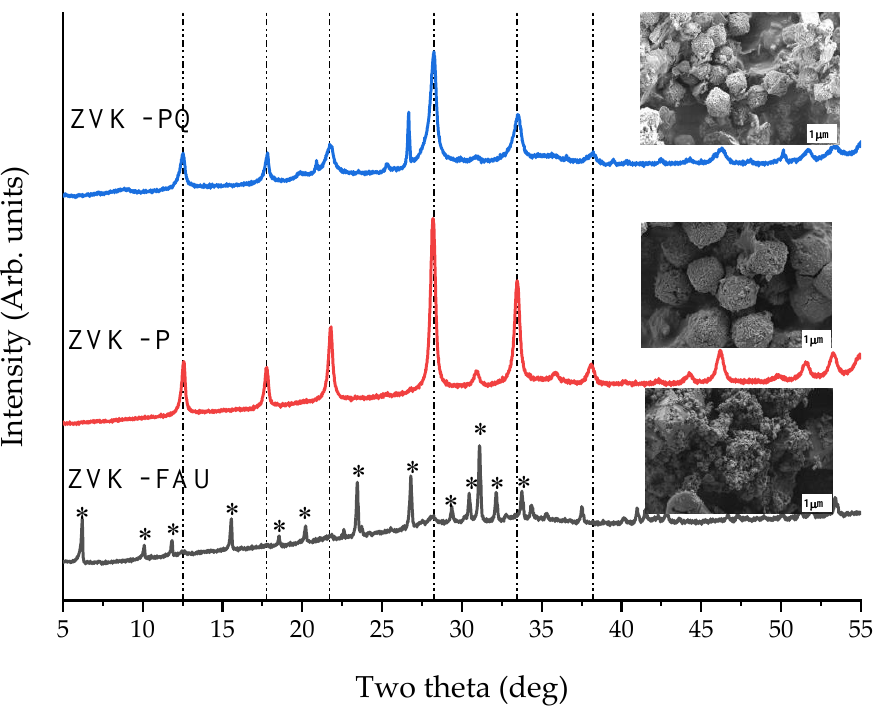
Figure 3. XRD patterns of zeolites from VK with no pretreatment (ZVK-FAU) and pretreatments via thermal activation (ZVK-P) and acid leaching (ZVK-PQ). Dashed lines represent the main GIS-NaP1 peaks, * FAU peaks. Inserts contain SEM images of the corresponding